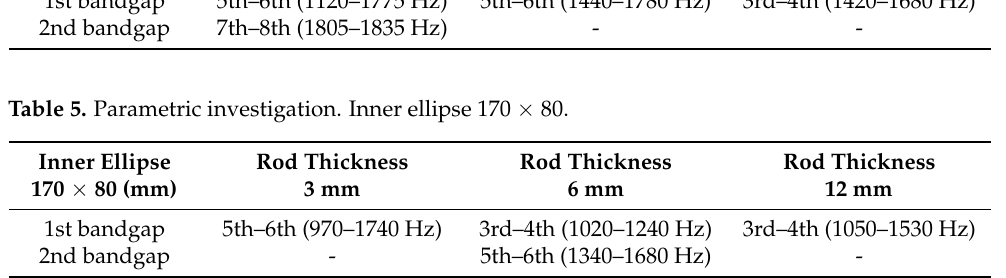
Table 4. Parametric investigation. Inner ellipse 170 × 60.